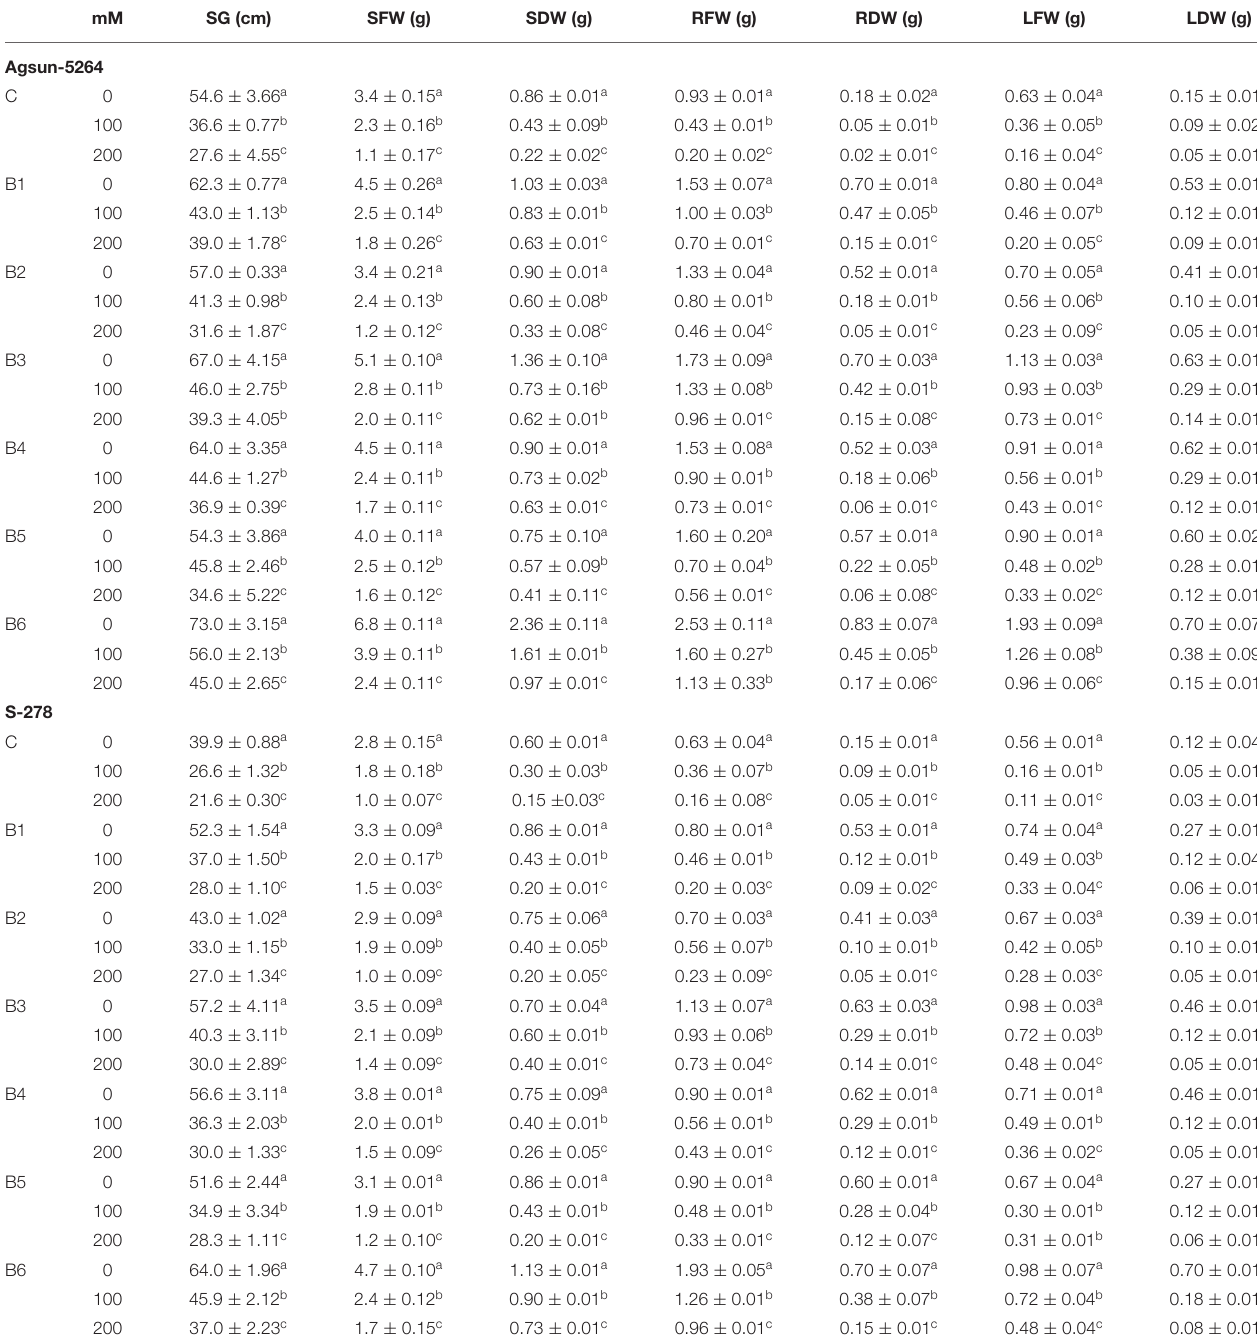
TABLE 1 | Interactive effects of microbial strains on morphological traits of sunflower cultivars saline